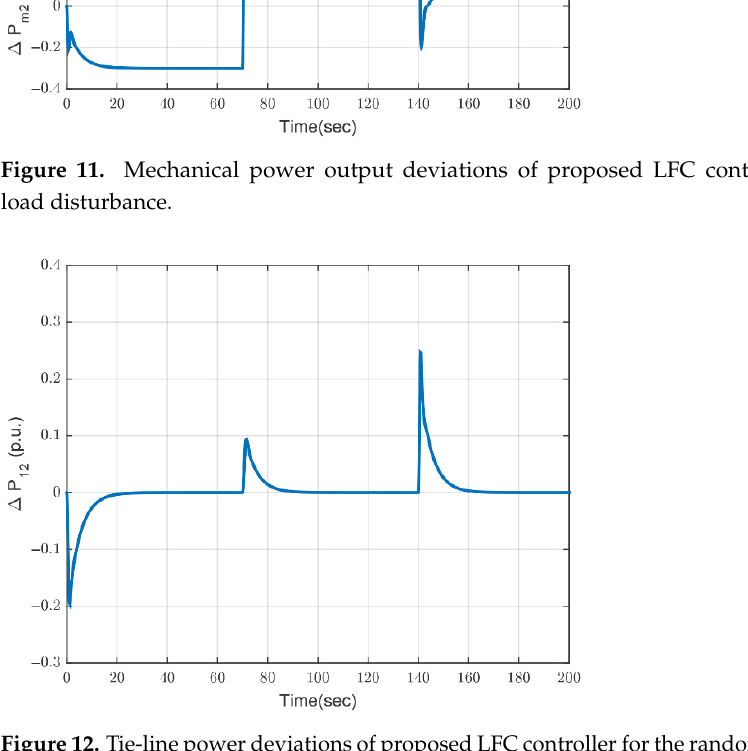
Energies 2022 , 15 , x FOR PEER REVIEW 16 of 20